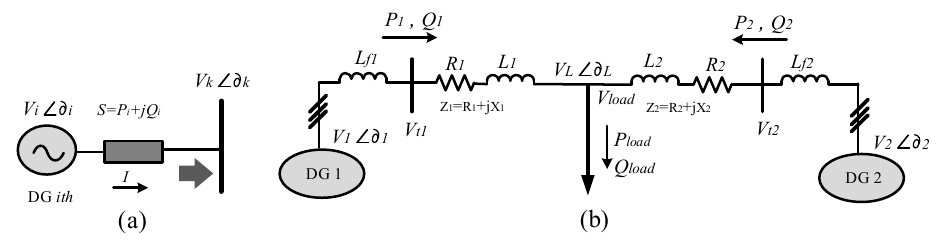
Figure 2. ( a ) An i th inverter connected with k th common ac bus; ( b ) configuration of the microgrid with two DG units.